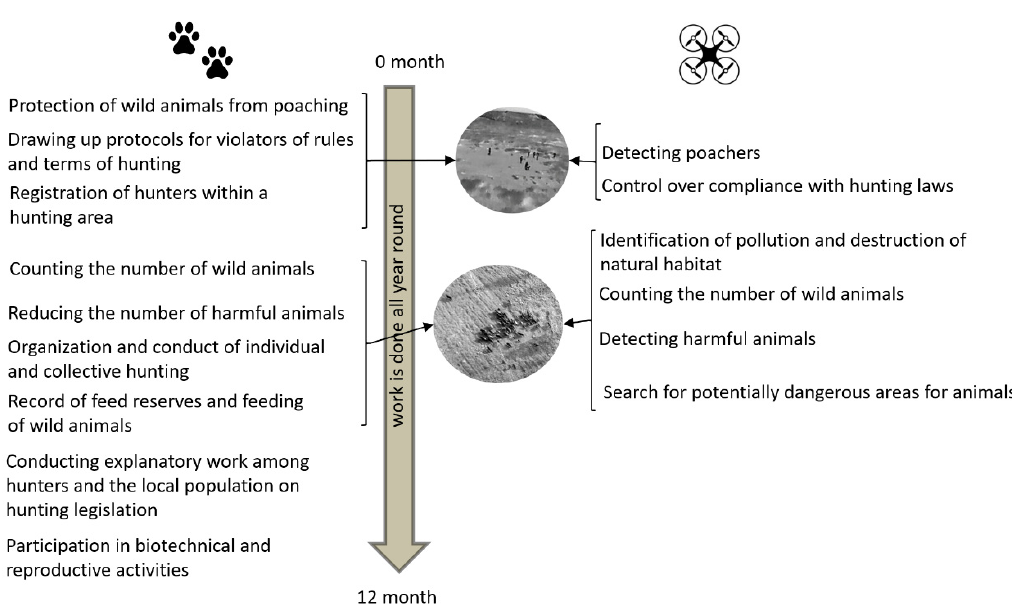
Figure 6. Monitoring of wild animal life. Source: Generated by the